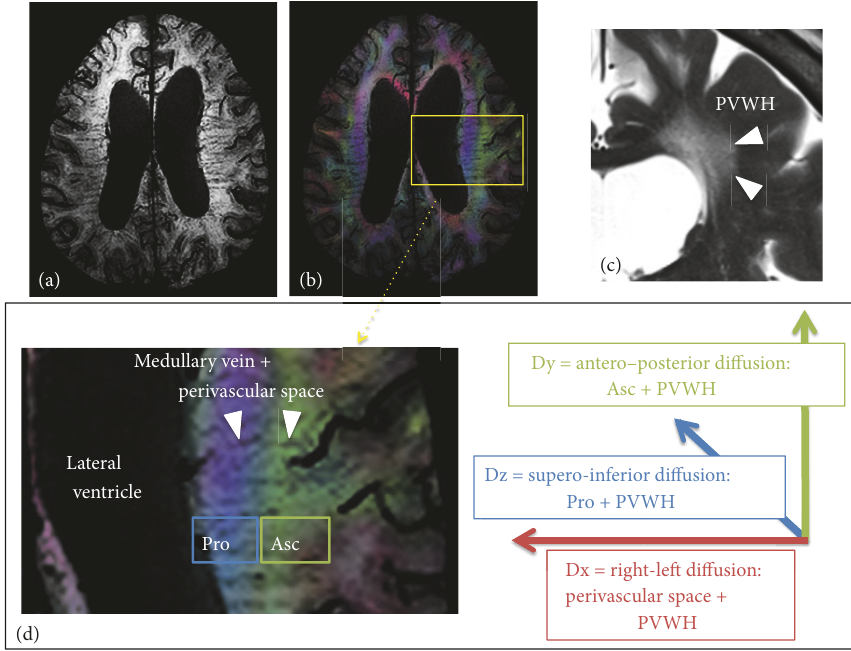
Figure 2: (a) Susceptibility-weighted image (SWI) shows the medullary veins running in the periventricular white matter. (b) Fusion of SWI and color-coded FA map. The periventricular white matter is divided into two regions; medial blue and lateral green areas, which correspond to the projection and association fibers, respectively. (c) In cases with ventriculomegaly, PVWH is often observed on T2-weighted image. (d) The medullary vein runs through the association and projection fiber areas (Pro and Asc). We hypothesized Dx reflects perivascular space of the deep white matter vessels and PVWH. Therefore, Dx partially include the glymphatic system. Dy and Dx are supposed to reflect the association fiber plus PVWH and the projection fiber plus PVWH,